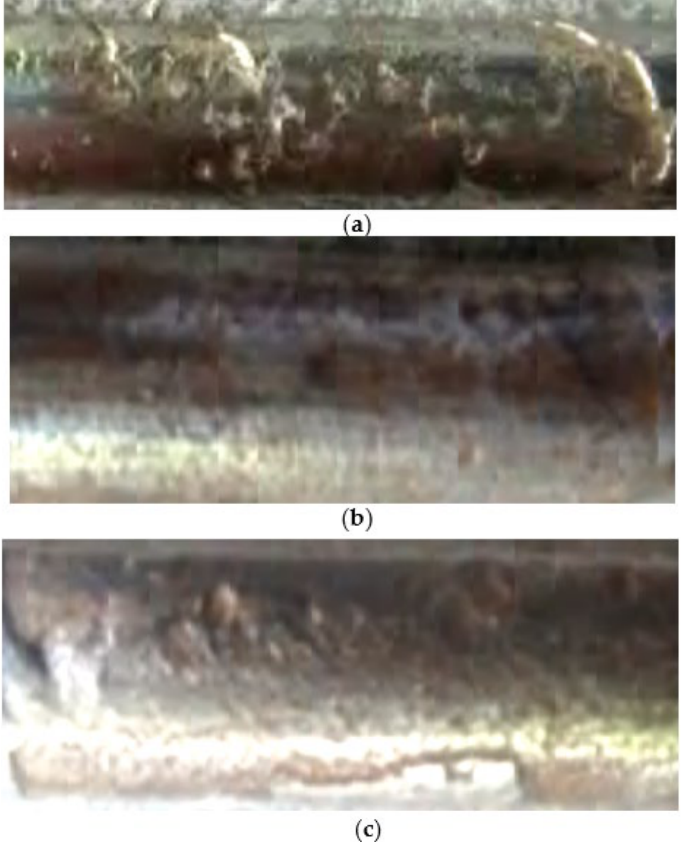
Figure 9. Corrosion morphology of prestressed rock bolt at different pH values. ( a ) pH = 14; ( b ) pH = 6.9; ( c ) pH = 9.